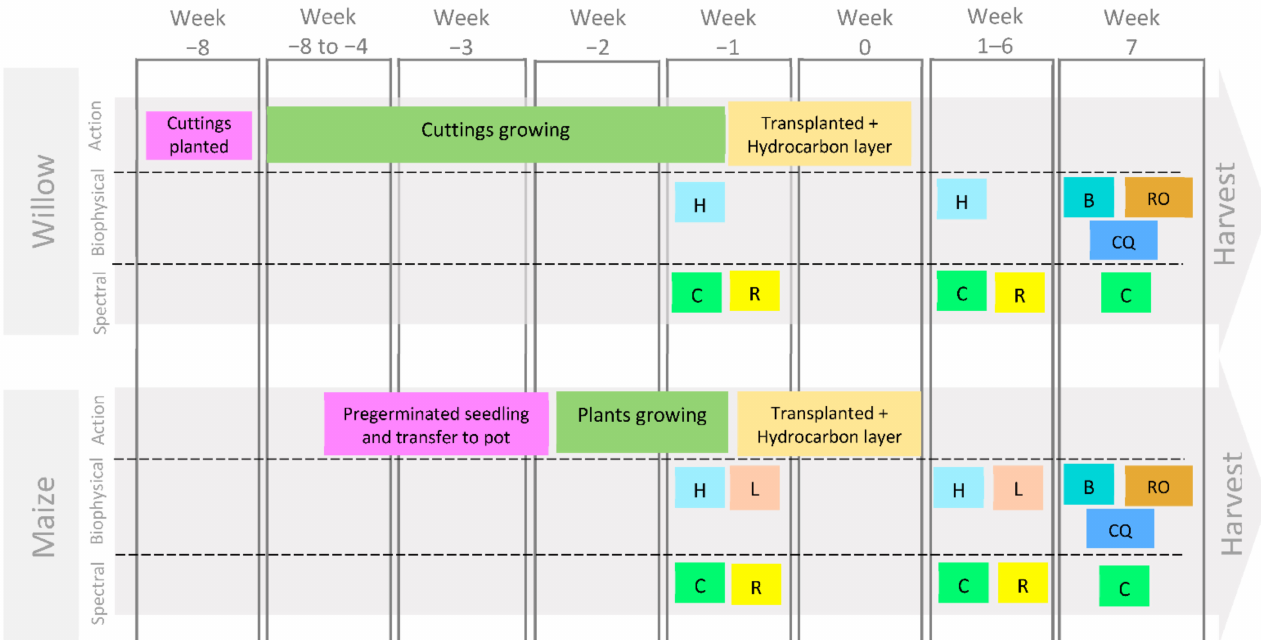
Figure 1. Experiment steps (Action), biophysical and spectral data collection for willow and maize. (L = leaf number, including colour; H = plant height, C = chlorophyll measured with MultispeQ, R = reflectance measured with ASD FieldSpec ® Pro 3, B = total plant biomass, RO = root observations, CQ = chemical analysis of